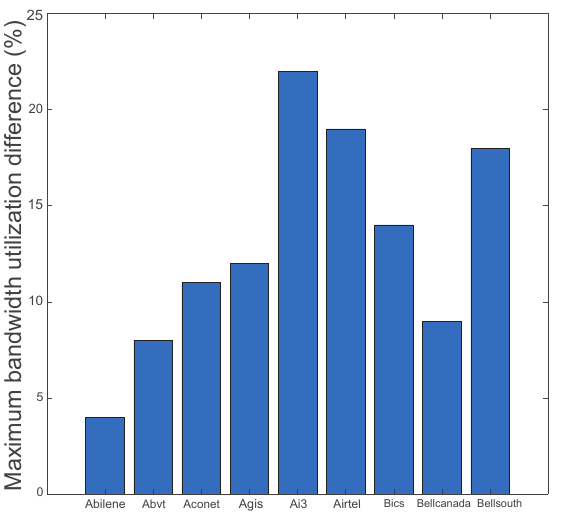
Fig. 10 Bandwidth difference for changing ˛˛˛